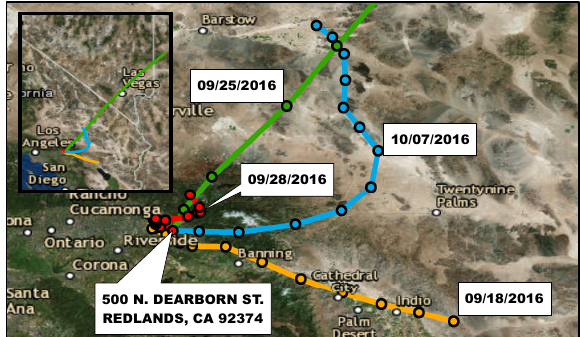
Figure 10. 12h back trajectories (each black circle represents 1h) starting at 15:00 local time computed using the HYSPLIT model for 2 weekdays (28 September and 7 October) and 2 Sundays (18 and 25 September). Meteorological variables at 15:00–16:00 and rBC physical properties are in Fig.